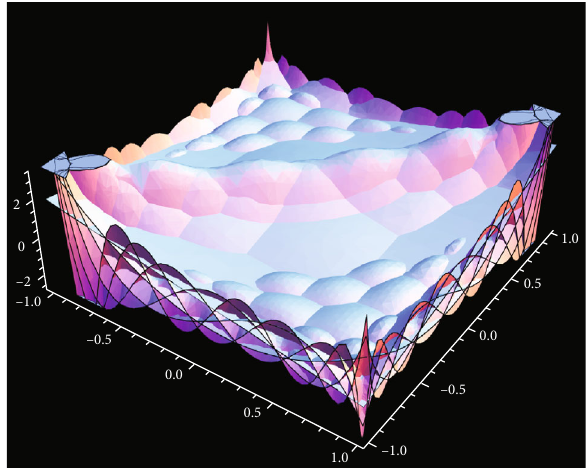
Figure 2: The set of reproducing kernel R α = β = 0